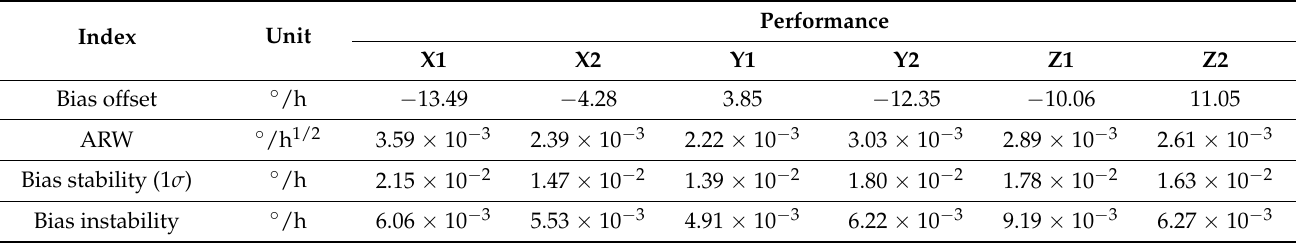
Table 1. Ground test results of the inertial measurement unit